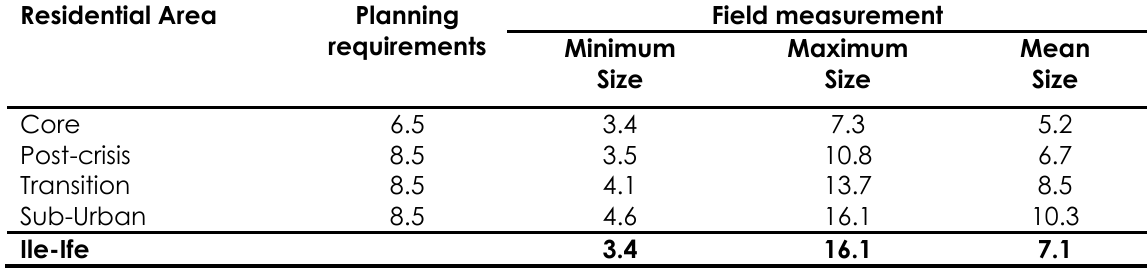
Table 1. The width of the marginal space in the different residential zones (in metres). Residential